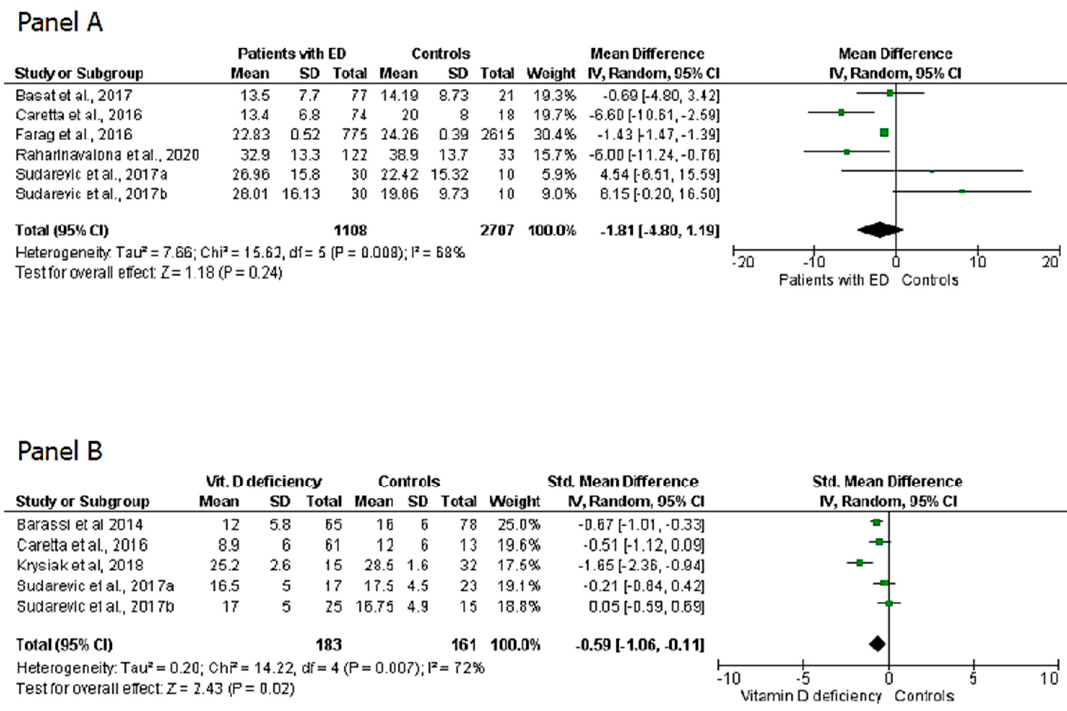
Figure 2. ( Panel A ) 25-hydroxy-Vitamin D levels in patients with erectile dysfunction and controls. ( Panel B ) International index of erectile function-5 scores in patients with Vitamin D deficiency vs. patients with vitamin D insufficiency or sufficiency.